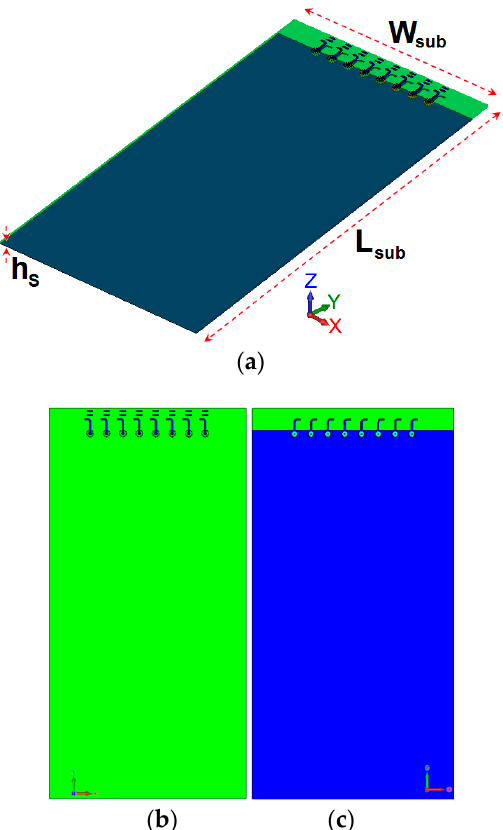
Figure 11. The mm-Wave smartphone antenna, ( a ) transparent, ( b ) top, and ( c ) bottom views.